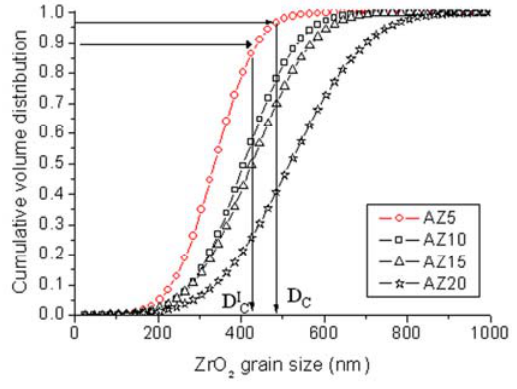
Figure 6. Cumulative volume distribution of ZrO and D is reported, as an example, for AZ5. estimation of D I C C